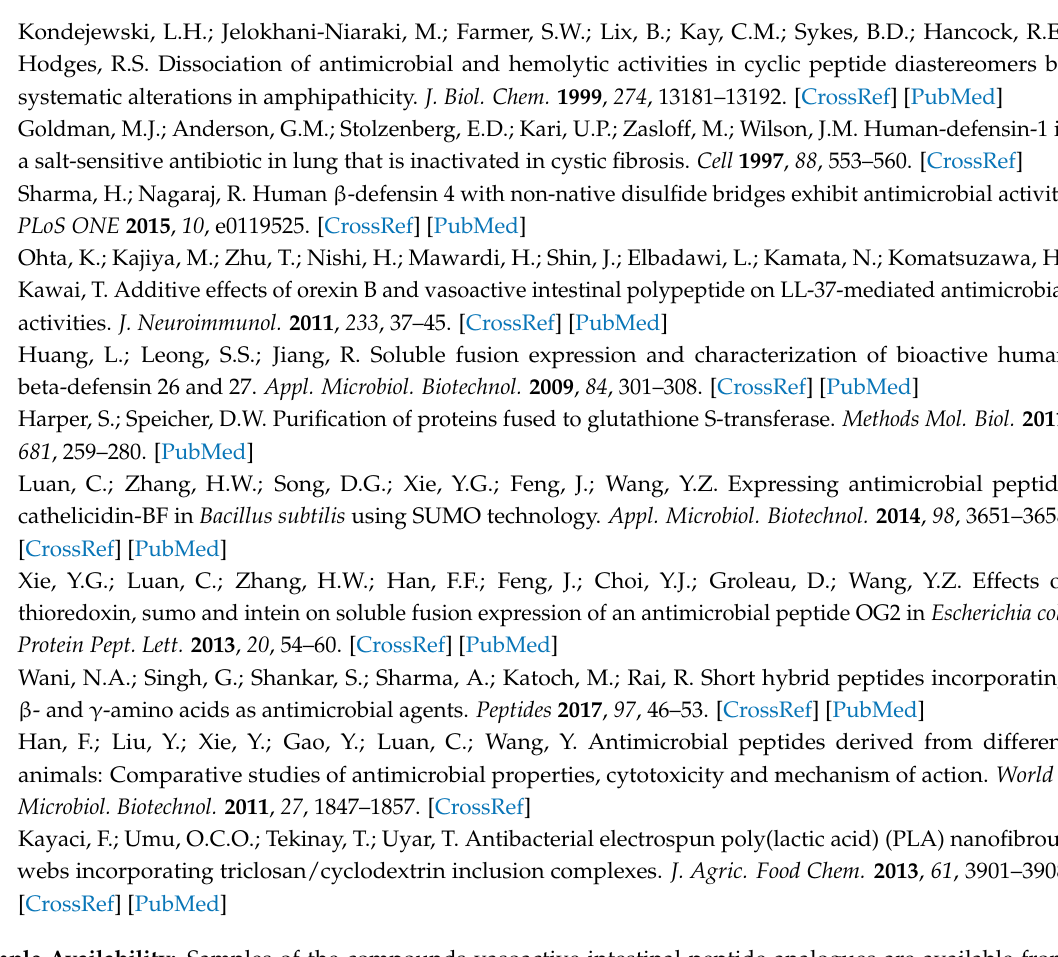
Sample Availability: Samples of the compounds vasoactive intestinal peptide analogues are available from the